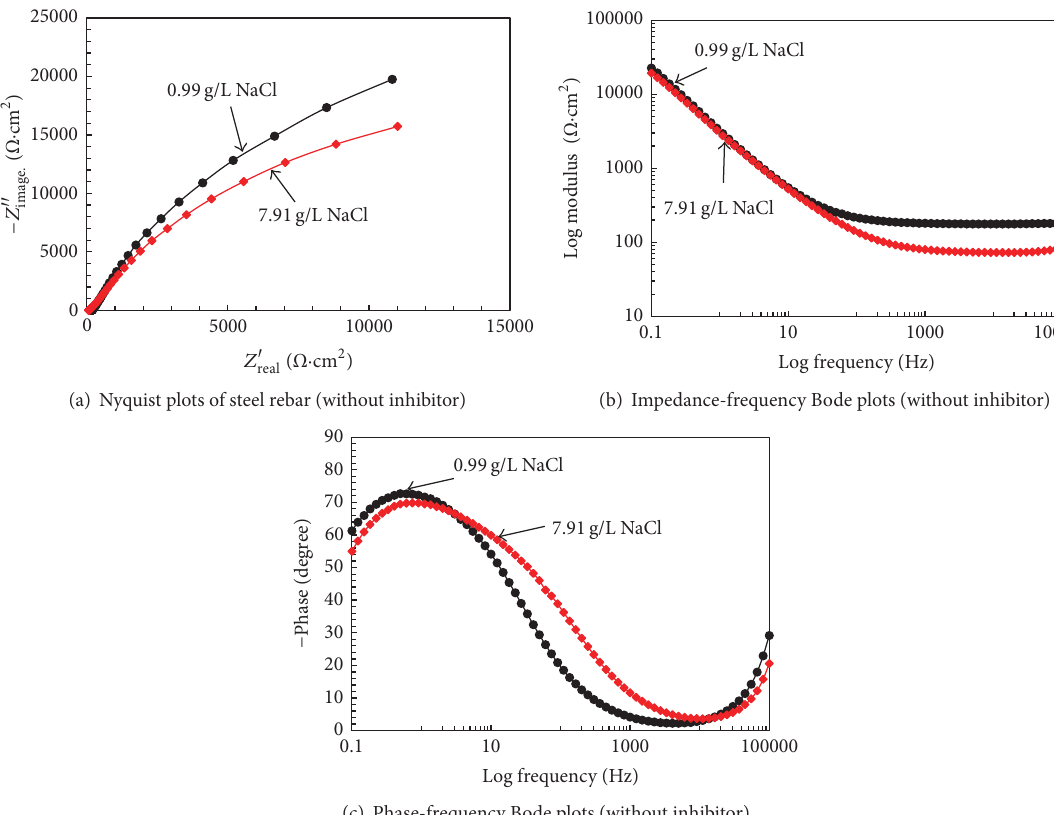
(c) Phase-frequency Bode plots (without inhibitor) Figure 3: Electrochemical plots of steel rebar exposed in saturated Ca(OH) 2 solution with different concentrations of NaCl.